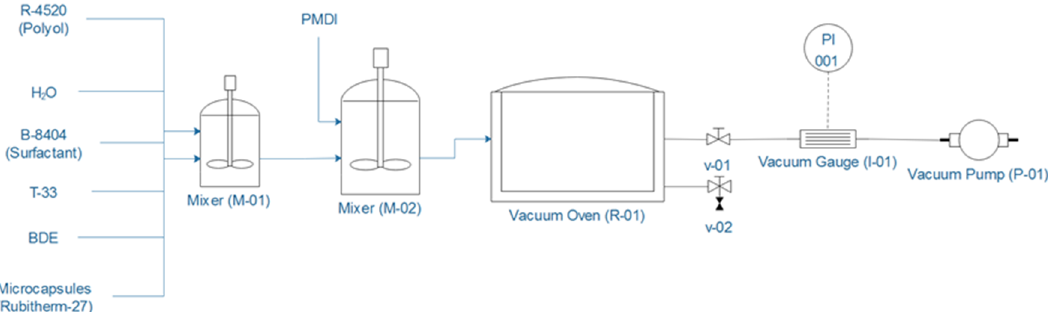
Figure 1. RPU foams synthesis facility scheme.